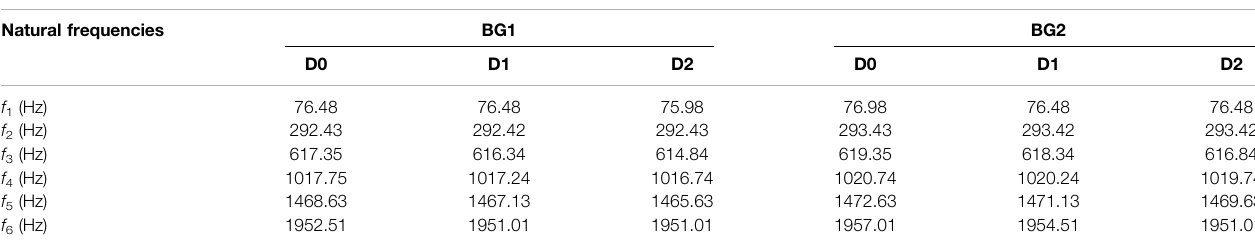
TABLE 3 | Comparison of frequency changes due to damage. Natural